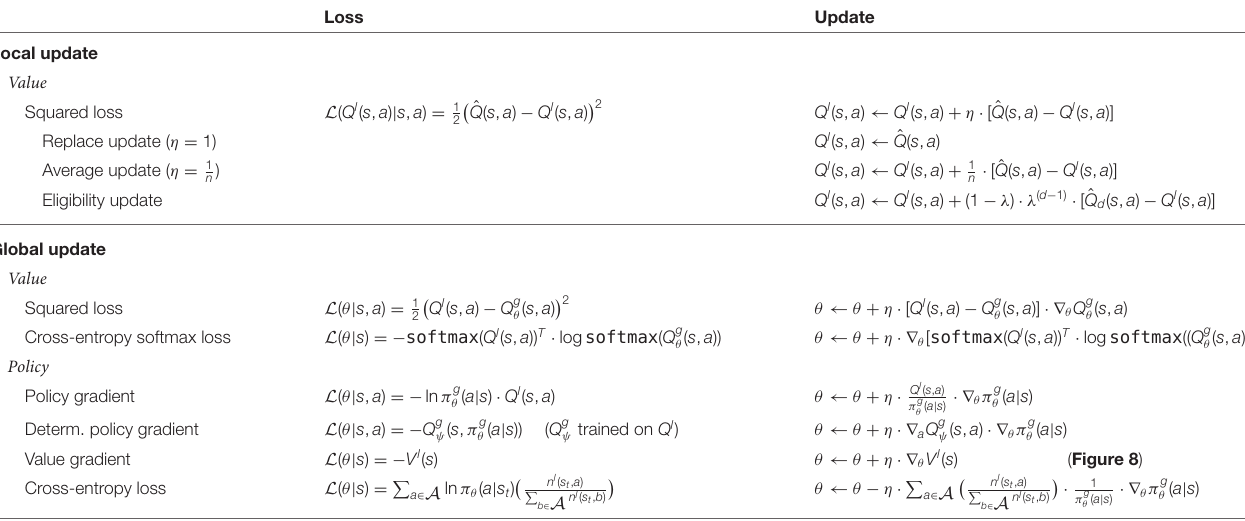
TABLE 6 | Overview of common loss functions and update